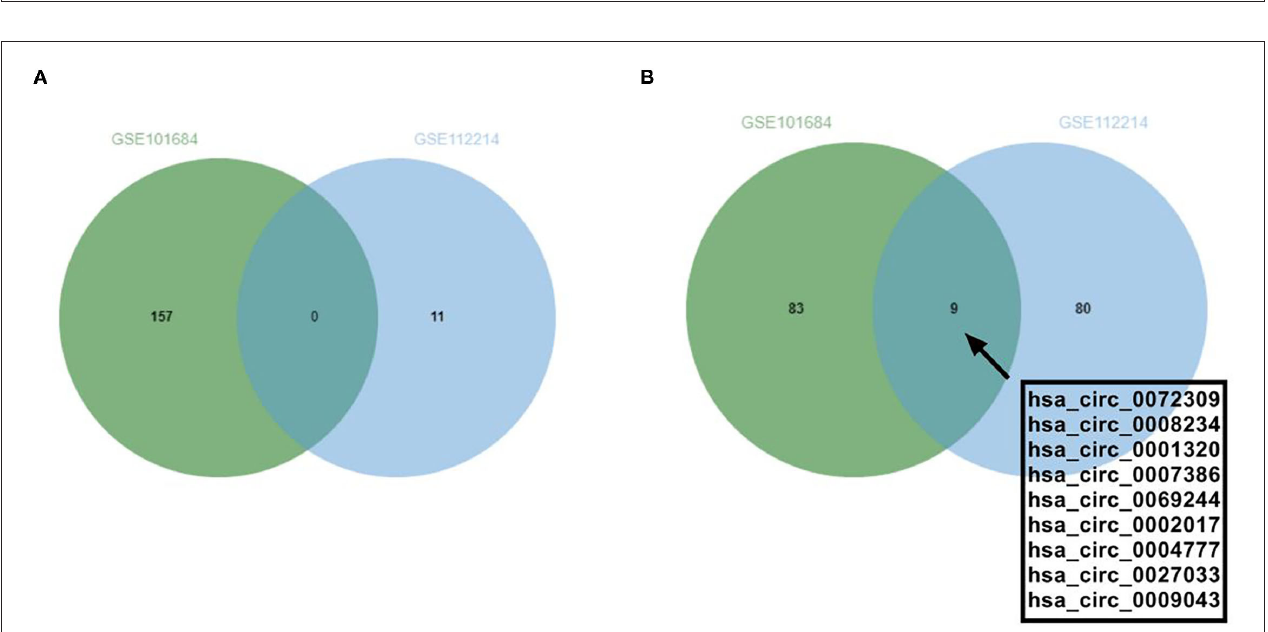
FIGURE 2 | Volcanic plot and heat map of circRNAs with aberrant expression in the GSE112214 microarray. (A) . Volcanic plot of differentially expressed circRNAs in the GSE112214 microarray: Red, blue and gray indicate those with high, low, and undifferential expression, respectively. (B) . Heat map of circRNAs with aberrant expression in the GSE112214 microarray.